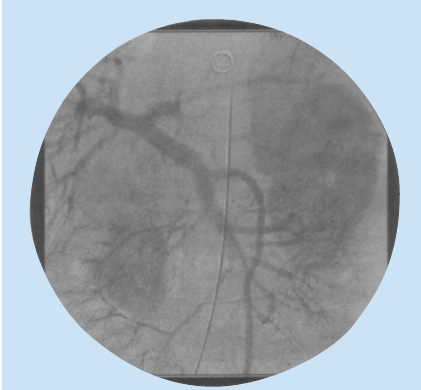
Fig. 3. Amain prerequisite for a successful TIPSS procedure is initial confirmation of a patent portal vein, as in this indirect